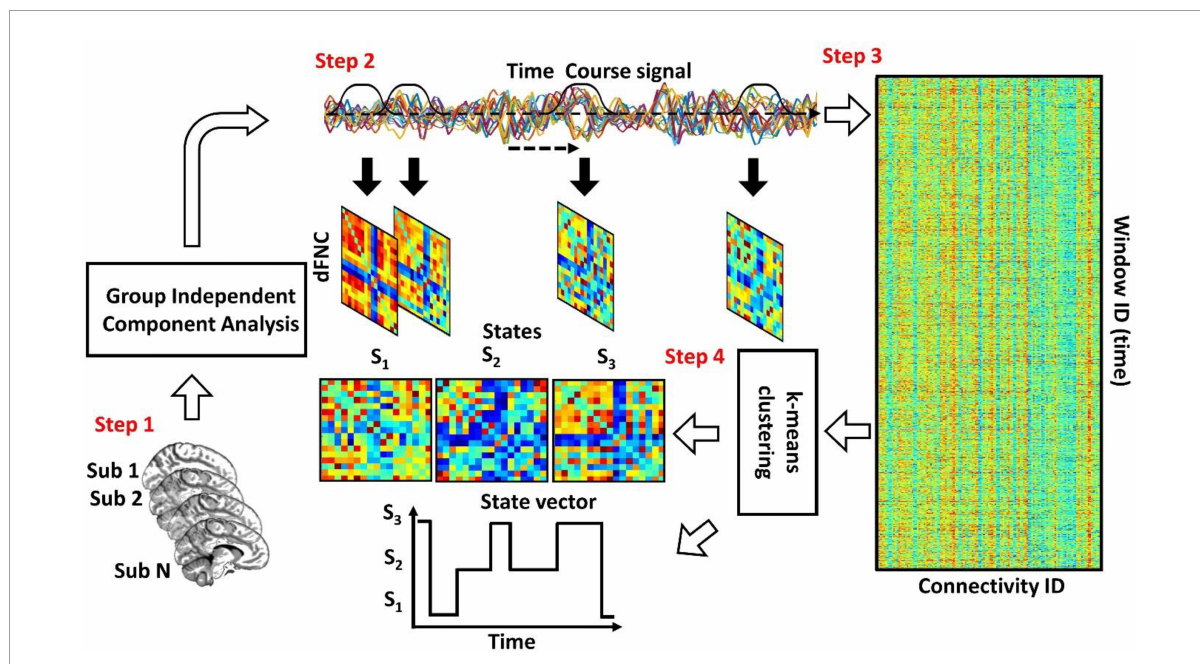
FIGURE1 The conventional dFNC pipeline. In Step 1, we estimate the independent components using group independent component analysis. In Step 2, we estimate the dFNC using sliding window. In Step 3, we concatenate all dFNCs across all participants. Then, based on elbow criteria, we estimate the cluster order. In Step 4, we use a standard kmeans clustering approach and calculate the dFNC state for group and state vector for